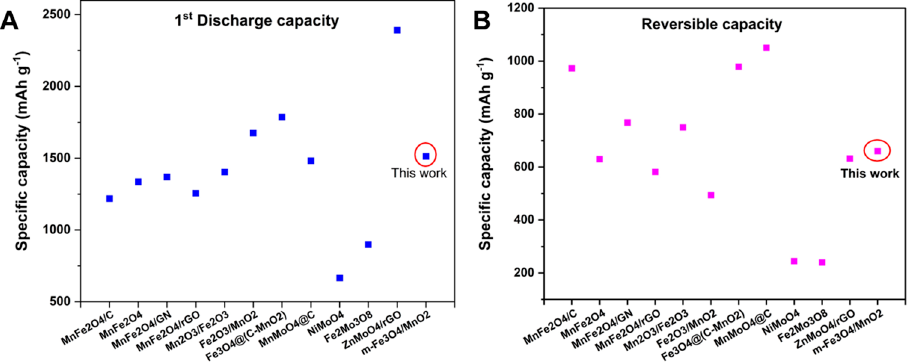
Table 1. Comparative data of various synthesis methods for Fe 3 O 4 @MnO 2 nanocomposite with the Figure 9. Electrochemical performance-comparison chart of manganese − based anodes. Figure 9. Electrochemical performance-comparison chart of manganese-based current method.